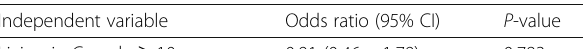
Table 9 Construct Validity* Association between years lived in Canada and the uptake of CRC